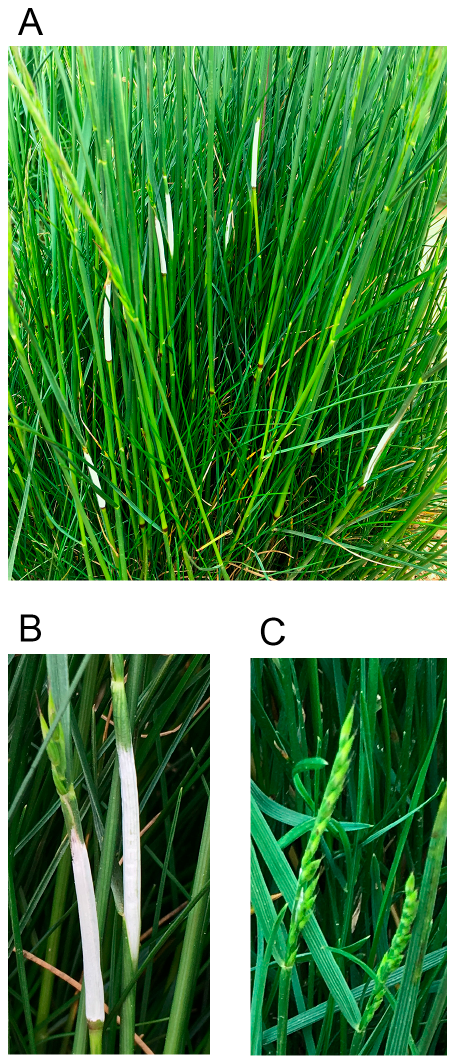
Figure 1. ( A ) Strong creeping red fescue plant with choke stromata and asymptomatic inflorescences. ( B ) Choke stromata. ( C ) Asymptomatic inflorescences.